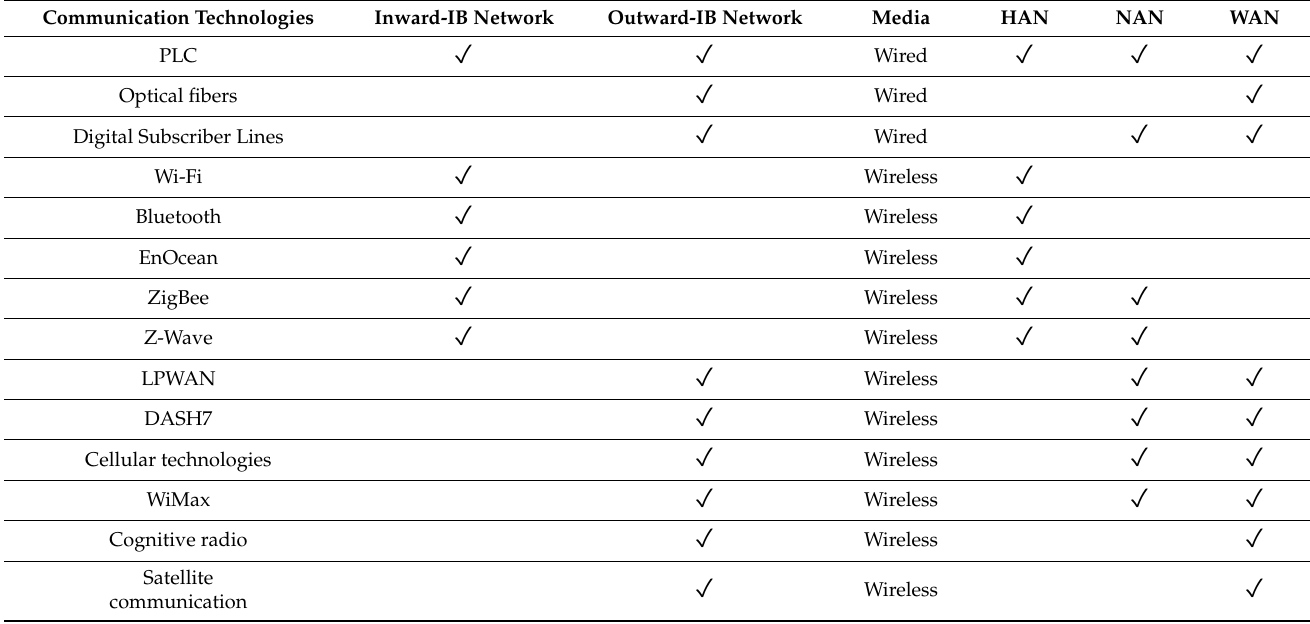
Table 2. Main communication technologies for Inward-IB and Outward-IB networks.